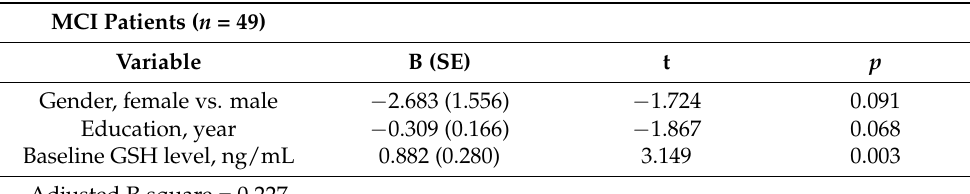
Table 3. Multiple linear regression analyses of independent factors (including baseline GSH level) associated with cognitive change, measured by ADAS-cog score change from baseline to endpoint at month 24, in MCI patients (stepwise).